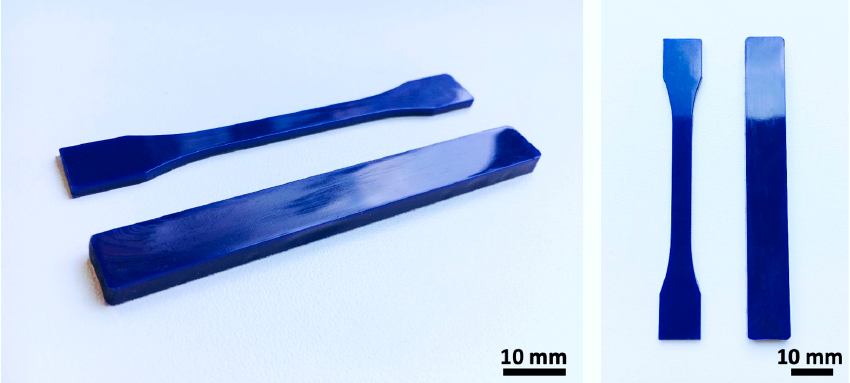
Figure 3. Images of the mechanical test specimens after molding process from different views.